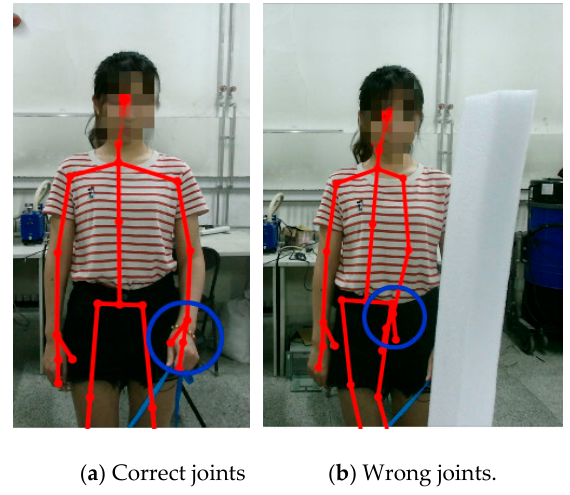
Figure 1. Visualization of skeleton tracking.